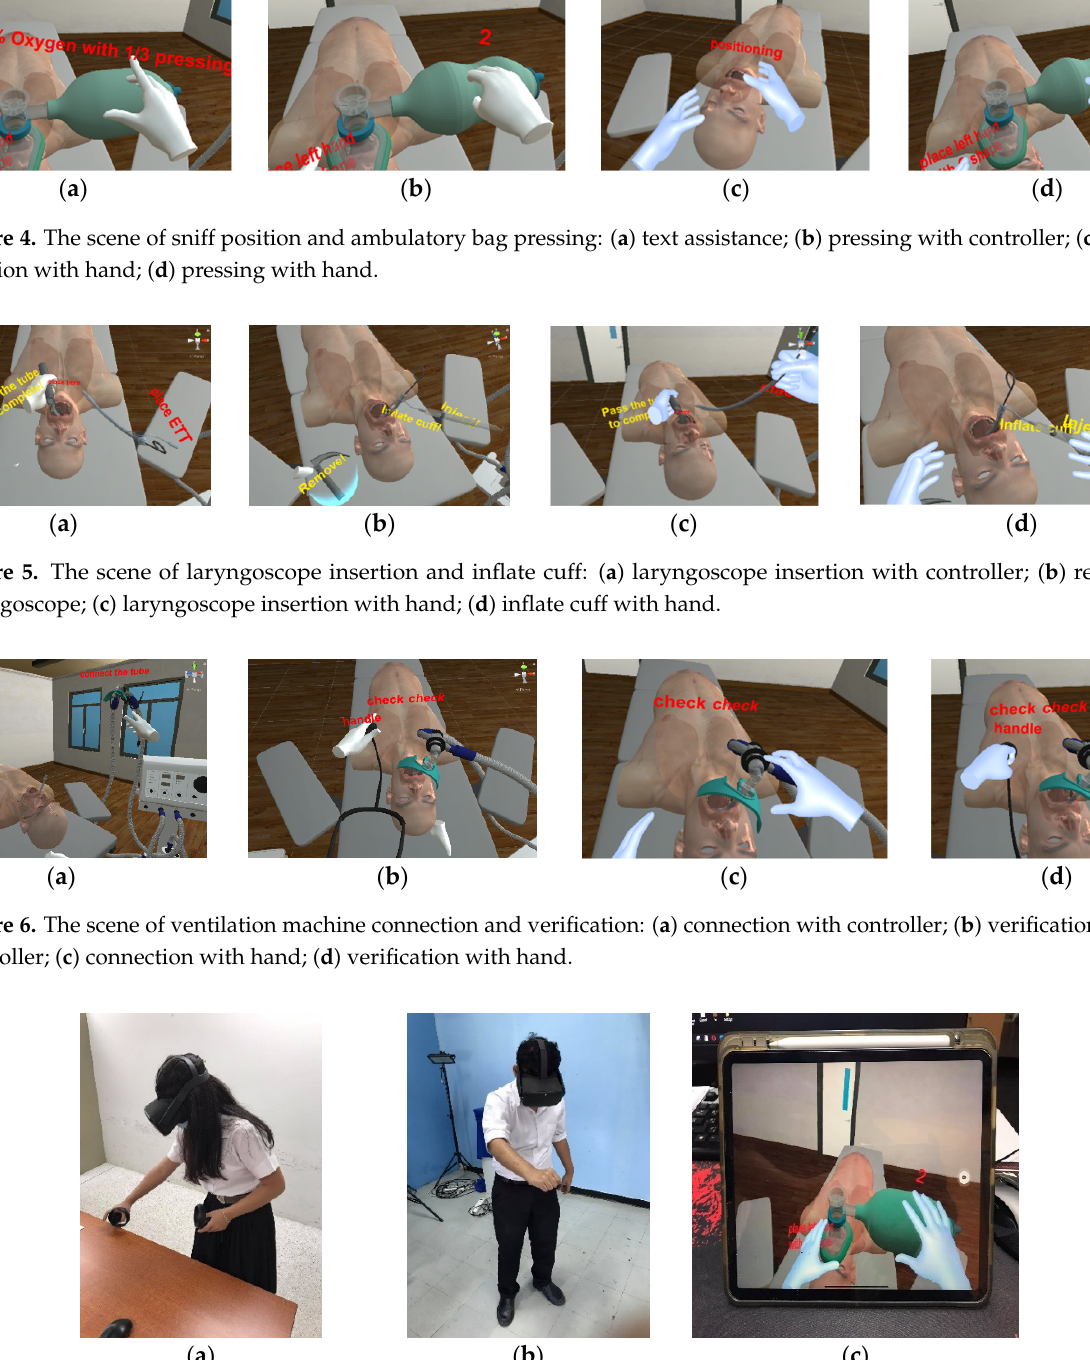
Figure 3. Introduction scene, pick up and drop the equipment according to its name: ( a ) virtual hand of the controller; ( b ) selection with controller; ( c ) selection with hand (grabbing); ( d ) release (unhand).